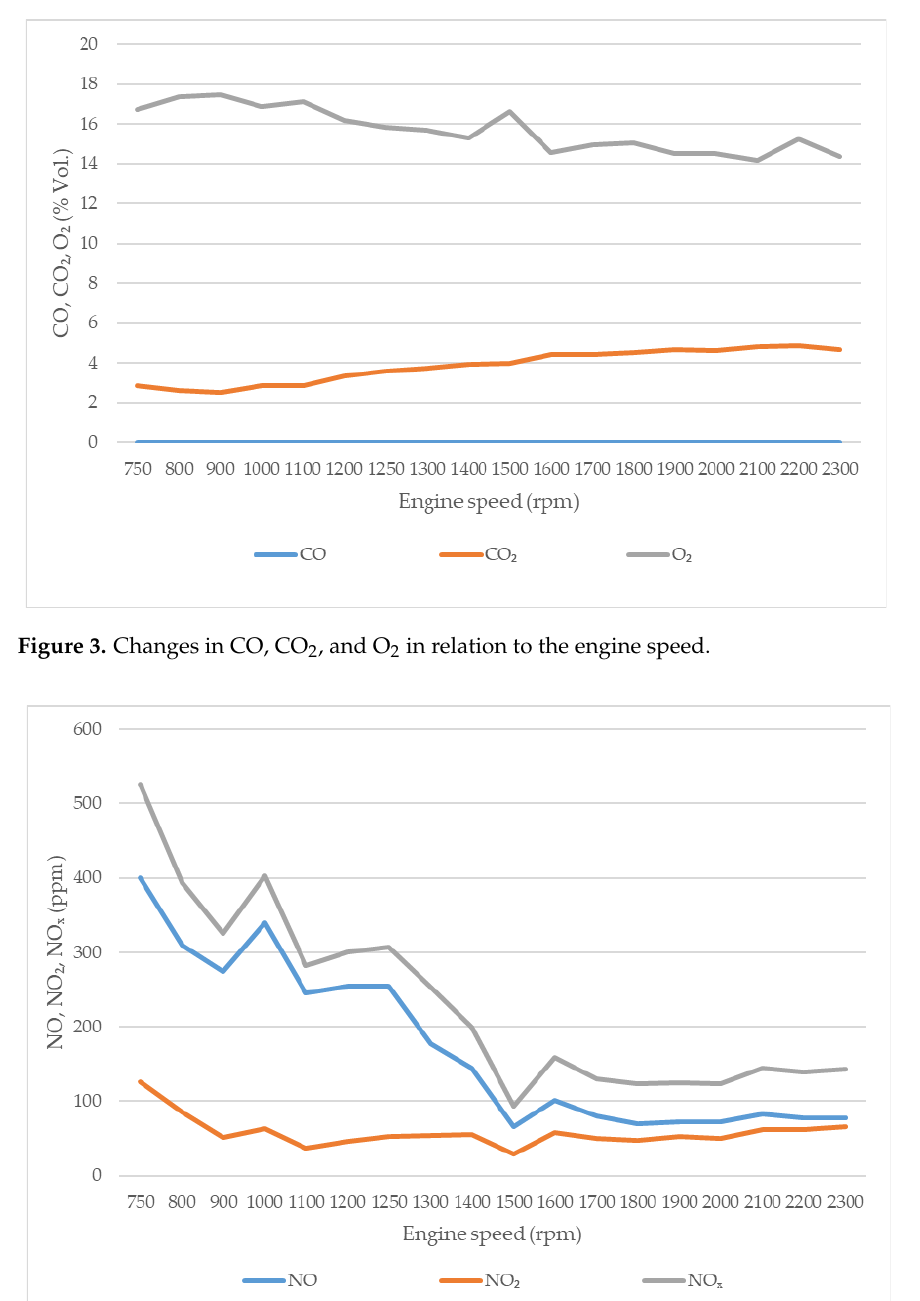
Figure 5. Changes in HC, NO, NO 2 , and NO x concentrations in relation to engine temperature. The concentration of hydrocarbon compounds (HC) had no continuous upward or downward trend and showed no dependence on engine speed. It was found that changes in the concentration of HC compounds in an unloaded engine are most influenced by engine temperature (Figure 5). The highest HC concentrations appeared at lower starting